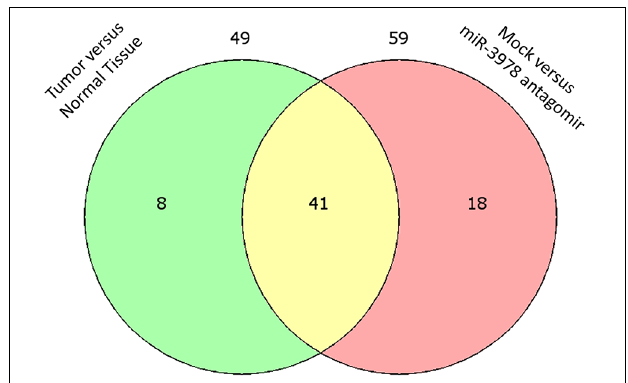
FIGURE 1 | Differential translation of EMT effector genes in metastatic gastric cancer. Venn diagram showing overlap of differentially translated genes when peritoneal gastric cancer and adjacent normal control tissue specimens were compared to differential translation of same genes in mock transfected or miR-3978 antagomir transfected normal human mesothelial cell line HMrSV5 (also refer Supplementary Tables S1 , S2